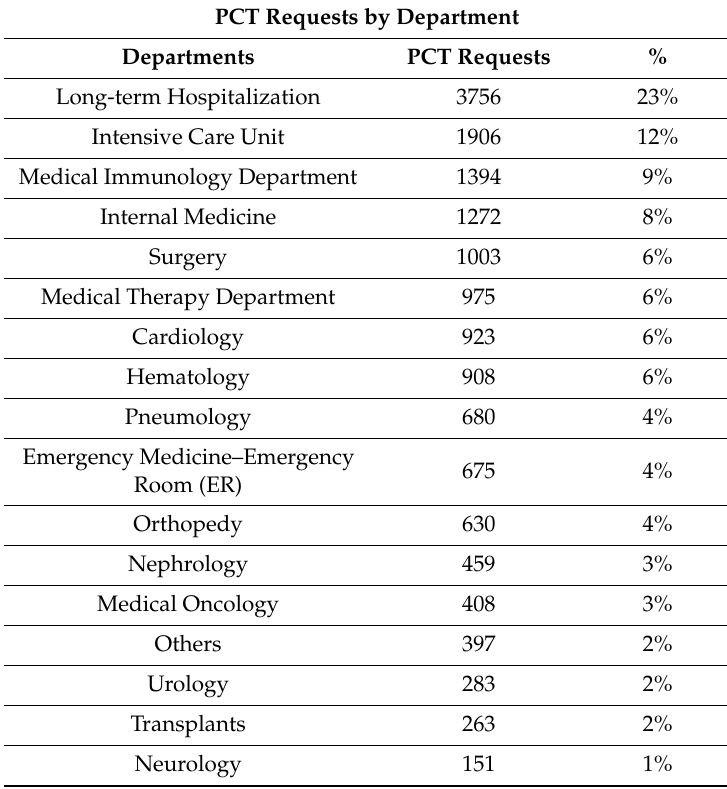
Table 1. Departments that requested procalcitonin